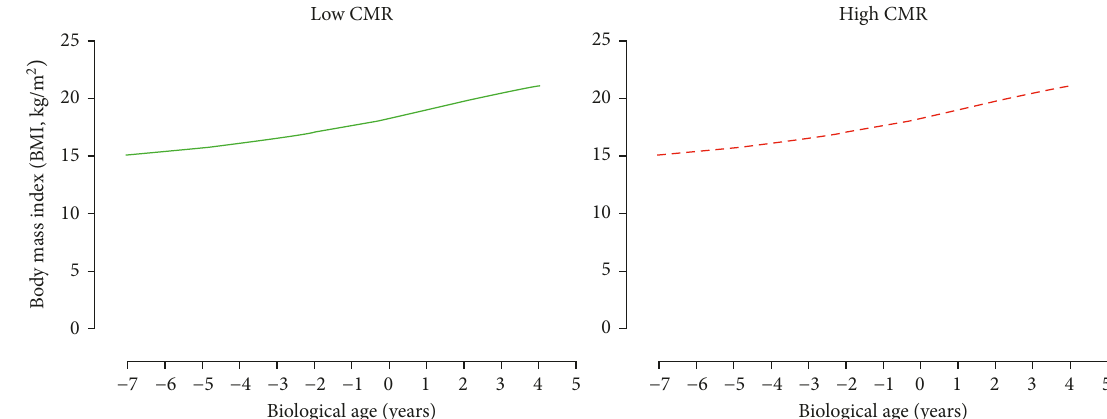
Figure 5: Predicted adolescent body mass index growth trajectories for individuals categorized as having low and high cardiometabolic risk (CMR) in adulthood. Predicted models adjusted for biological age, height, and